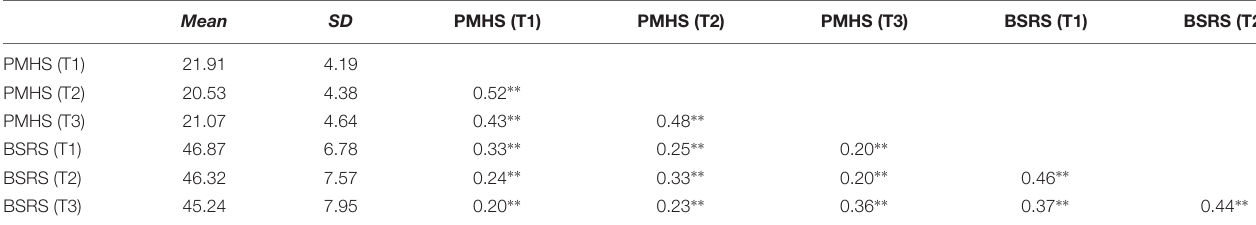
TABLE 1 | Means and standard deviations ( SDs ) descriptions and correlations between positive mental health and social rhythm at each time